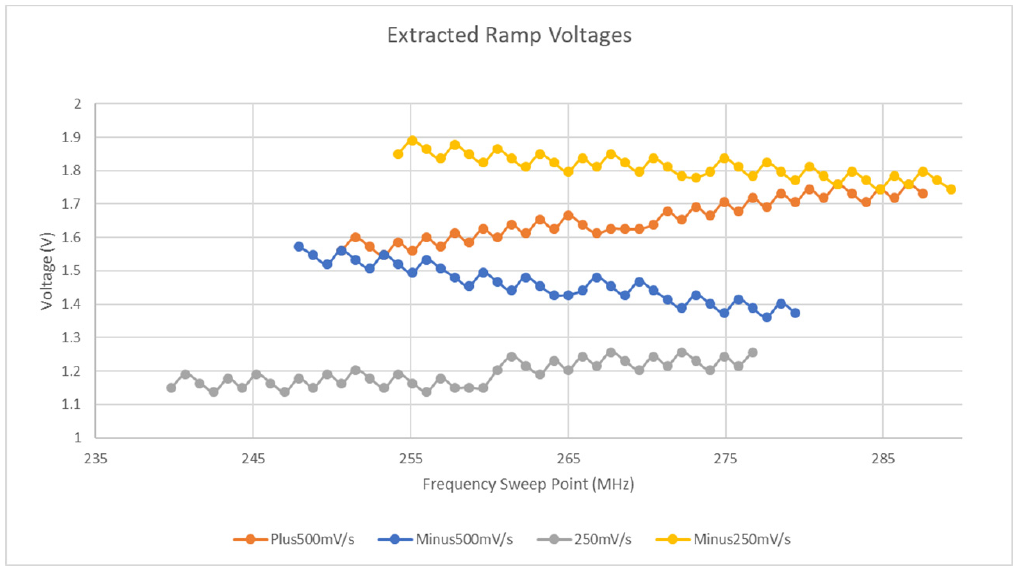
Figure 14. Extracted Ramp Voltages.